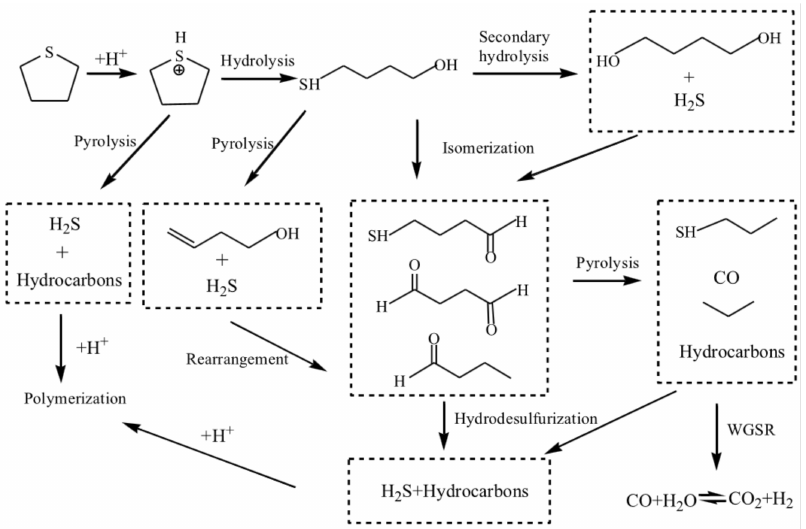
Figure 2. Reaction pathways for tetrahydrothiophene